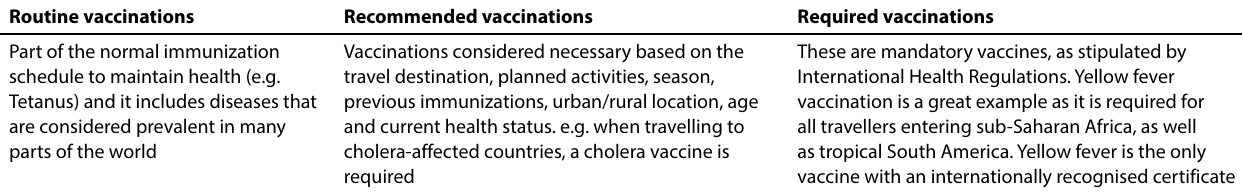
Table 1: Vaccination terminology Routine vaccinations Recommended